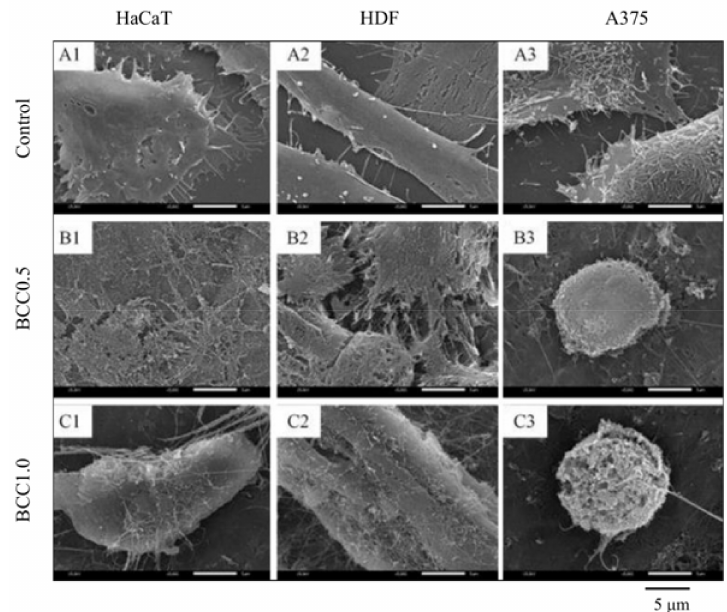
Figure 7. SEM images (5000 × magnification) showing cytotoxic effects of BCC0.5 (Row B ) and BCC1.0 (Row C ) against plain cover class (Row A , control) on HaCat (Column 1 ), HDF (Column 2 ), and A375 (Column 3 ) cells after 24-h treatment.